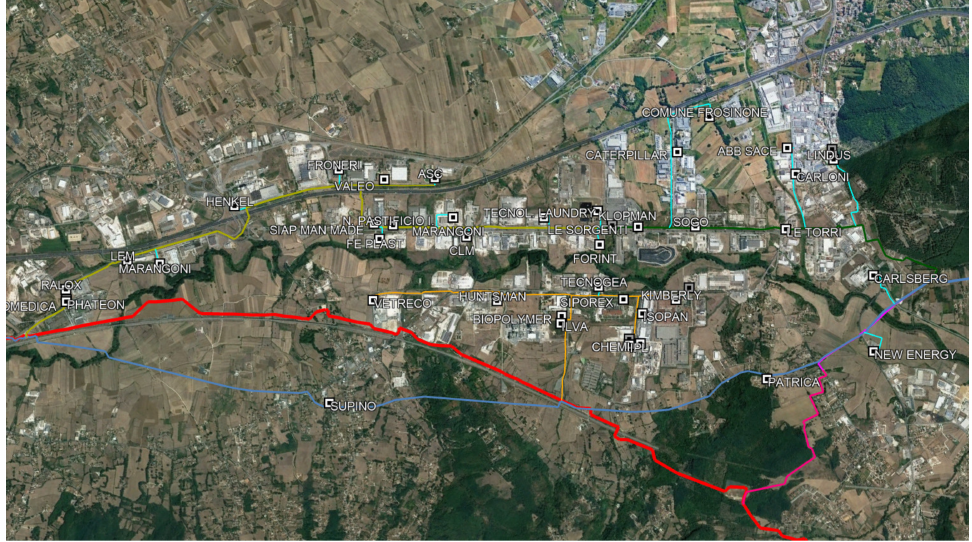
Figure 1. Frosinone–Ferentino industrial area